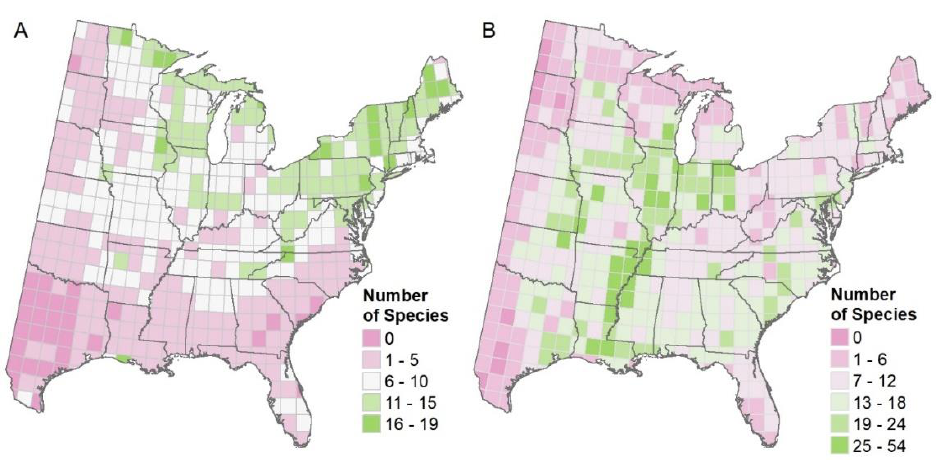
Figure 7. ( A ) The number of species that may potentially migrate into each 1 × 1 degree cell (from elsewhere), within 100 years across the eastern US (Migrate + plus Migrate ++ ), under RCP 8.5. ( B ) The number of species with potential to infill (Infill + plus Infill ++ ) into each 1 × 1 degree cell, within 100 years, across the eastern US.